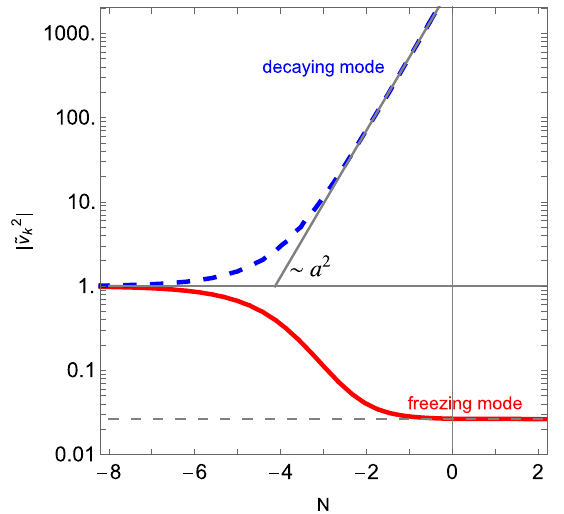
line corresponds to the value (22). Right panel: evolution of the instan- taneous power spectra in the full theory and in the effective theory; color coding described in Table 1; thin dashed line corresponds to the asymptoticvalue(36). N = 0correspondstotheHubbleradiuscrossing is shown in Fig. 4. We again find exquisite consistency at all scales between the predictions of the full two-field model and the effective single-field theory with a MESS sound speed.